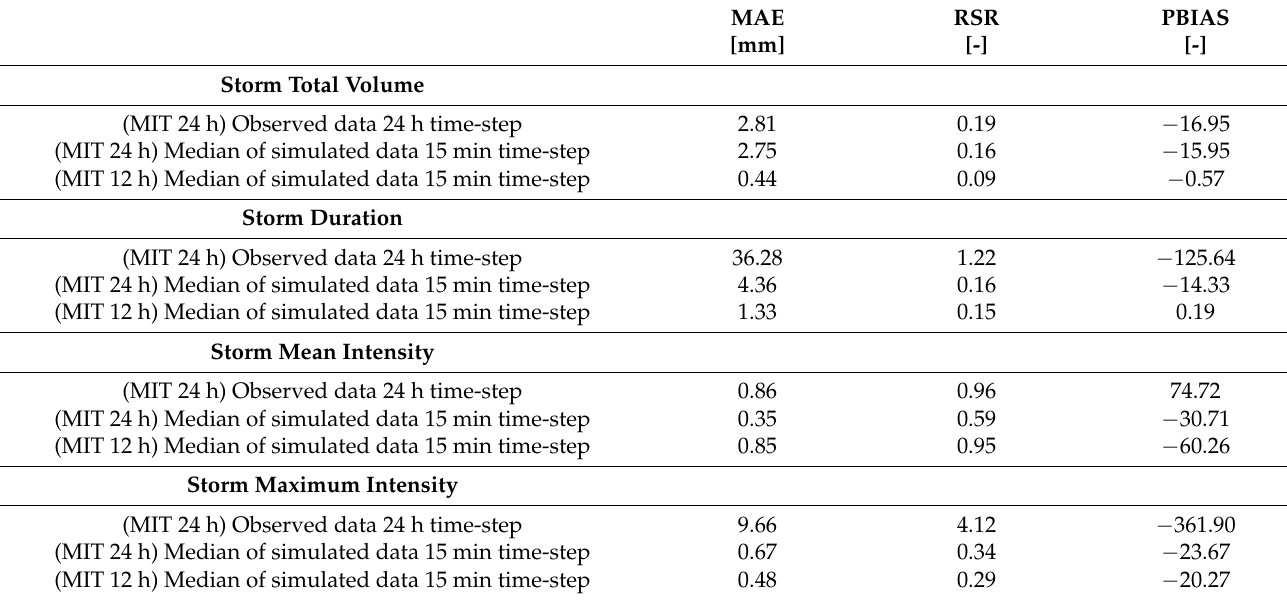
Table 2. Mean absolute error (MAE), root mean square error-observations standard deviation ratio (RSR) and Percent bias (PBIAS) calculated between key characteristics of observed rainfall with 15 min time-step, observed daily (24 h) rainfall and simulated rainfall with 15 min time-step. MIT are fixed to 24 and 12 h.